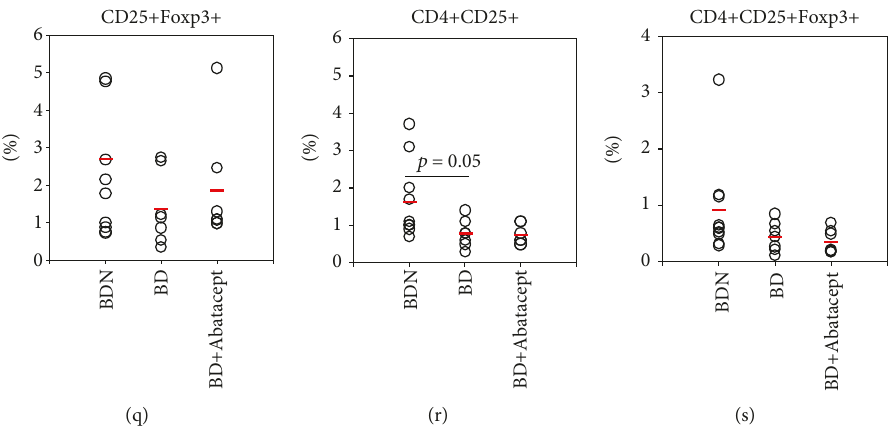
Figure 2: Abatacept a ff ected the frequencies of CD83+ cells in normal and BD mice. (a – d) Frequencies of DC costimulatory molecules CD40, CD83, CD80, and CD86 in normal mice treated with Abatacept in the surface of peripheral blood leukocytes were evaluated by FACS analysis ( n = 3 for each group). (e) Abatacept 2 mg for 1 to 3 days in normal mice was evaluated by FACS analysis ( n = 3 for each group). (f – i) Frequencies of CD40, CD83, CD80, and CD86 in BD mice treated with Abatacept were evaluated by FACS analysis ( n = 5 in normal, n = 5 in BD, and n = 8 in BD+Abatacept). (j, k) Abatacept treatment decreased the disease severity score and improved symptoms. (l) Representative histograms of CD83+ and CD86+ cell frequencies in PBL of BD mice treated with Abatacept. Regulatory T cells in BD mice were analyzed by FACS analysis. (m – s) Frequencies of CD4+, CD4+Foxp3+, CD4+CD25+, and CD4+CD25+Foxp3+ Treg cells in BDN, BD, and Abatacept-treated BD mice were evaluated by FACS analysis ( n = 10 in BDN, n = 7 in BD, and n = 5 in BD+Abatacept). n indicates the number of mice used in each group. The p value was determined by Student ’ s t -test. Experiments were performed more than three independent